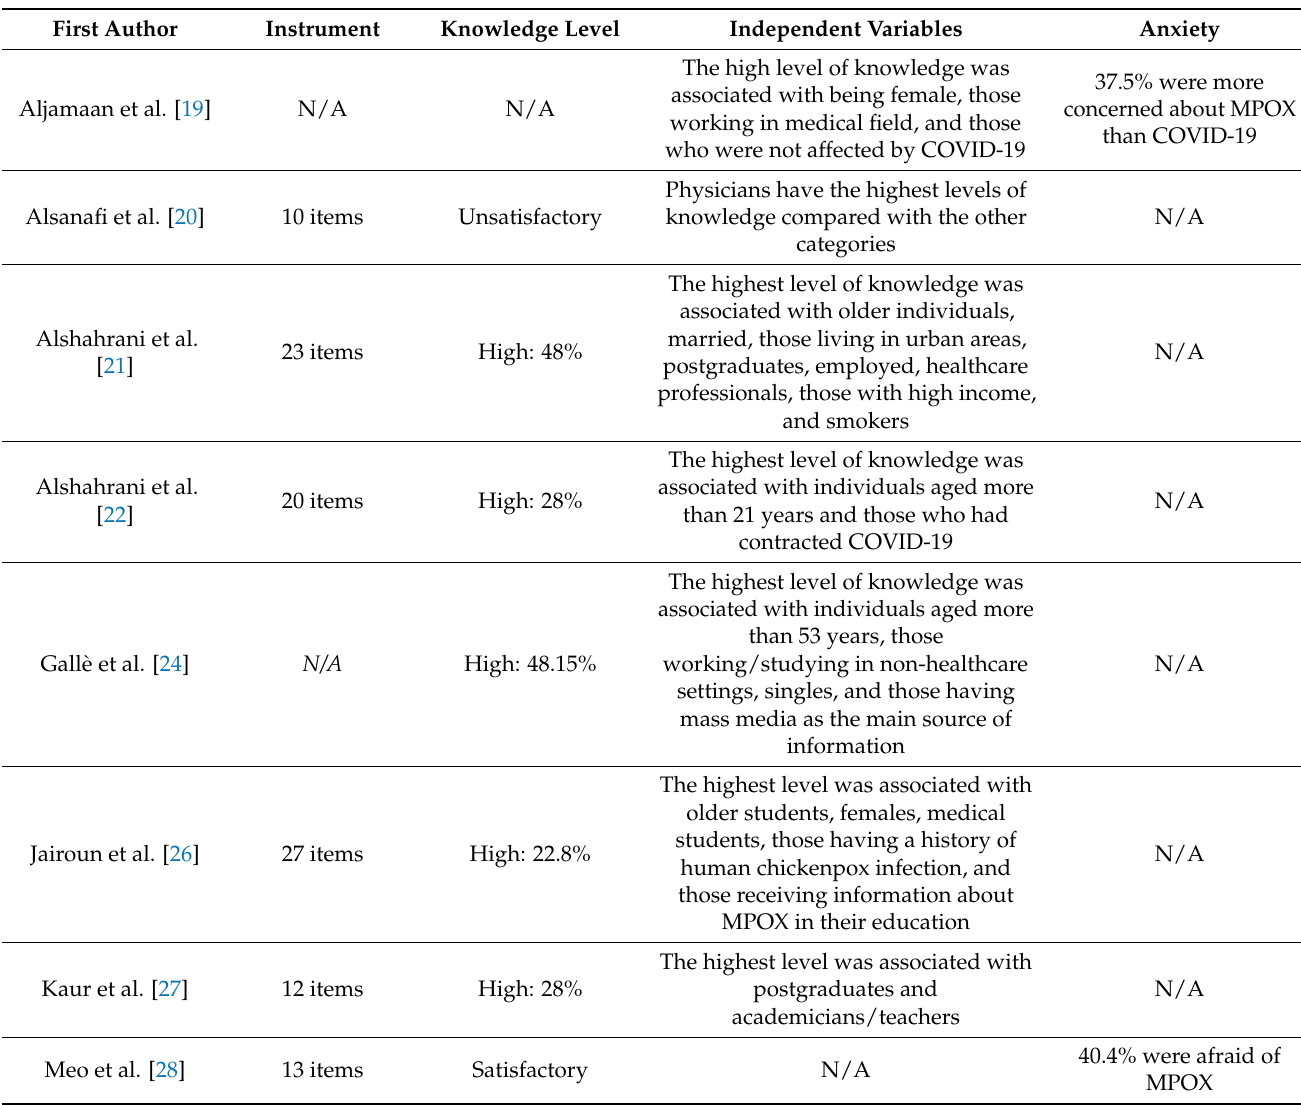
Table 2. MPOX-related Knowledge According to the Included